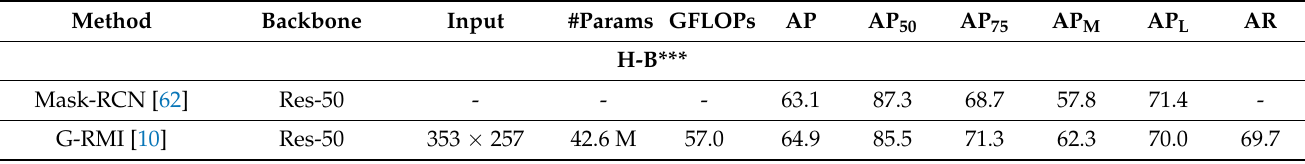
Table 4. Comparisons for the COCO test-dev set, with the exclusion of systems trained using external